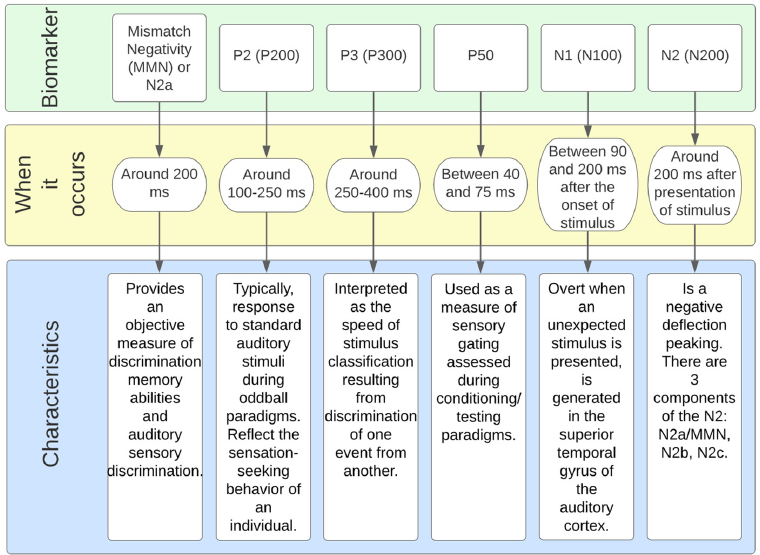
Figure 7. Biomarkers of ERP for schizophrenia